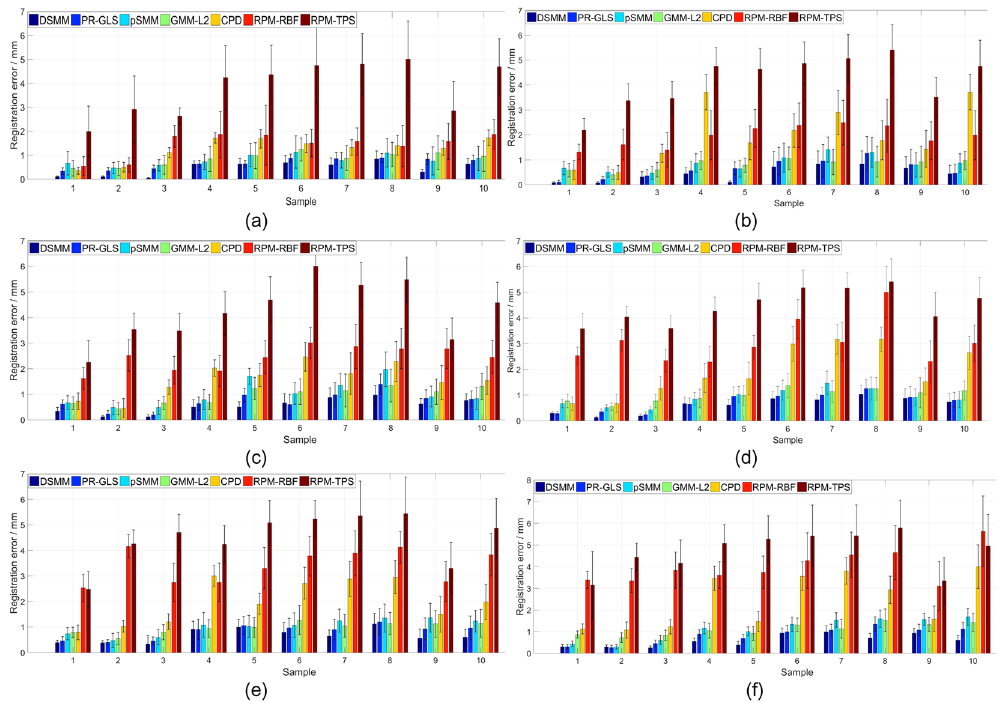
Figure 12. Quantitative evaluations of the non-rigid point set registration algorithms on the incomplete 3D lung data pairs of 4D CT images. ( a ) complete data, ( b ) 15 points removed, ( c ) 30 points removed, ( d ) 45 points removed, ( e ) 60 points removed, ( f ) 75 points removed.